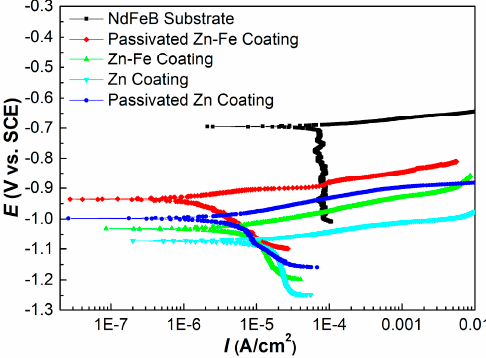
Figure 6. Polarization curves of different specimens in natural 3.5 wt.% NaCl solution.